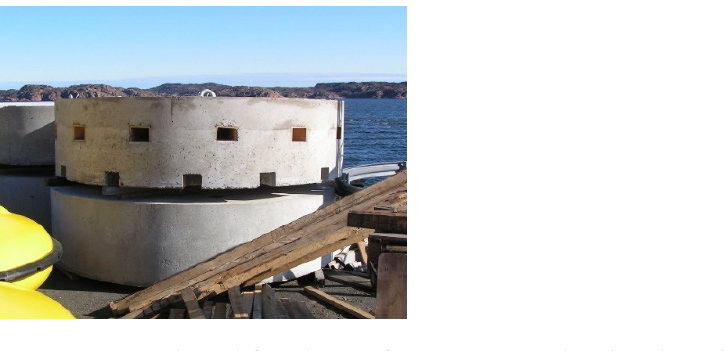
Figure 2. Two ecological foundations for environmental and ecological studies in the Lysekil wave power park research site. Upper ecological foundations include manufactured holes for increased complexity.